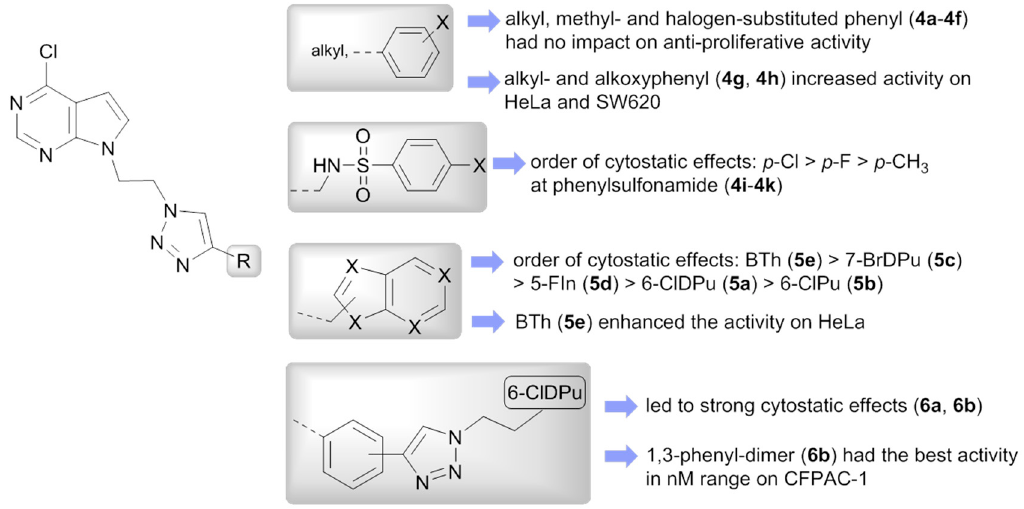
Figure 5. Structure-activity relationship (SAR) of a series of mono- ( 4a – 4k ) and bis-pseudopurines ( 5a – 5e , 6a and 6b ).